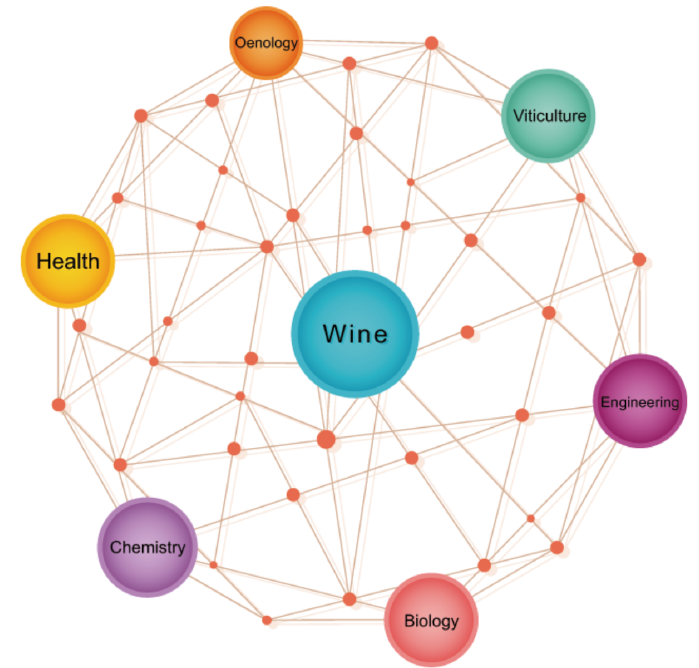
Fig. 1. Some research areas in which wine is the study